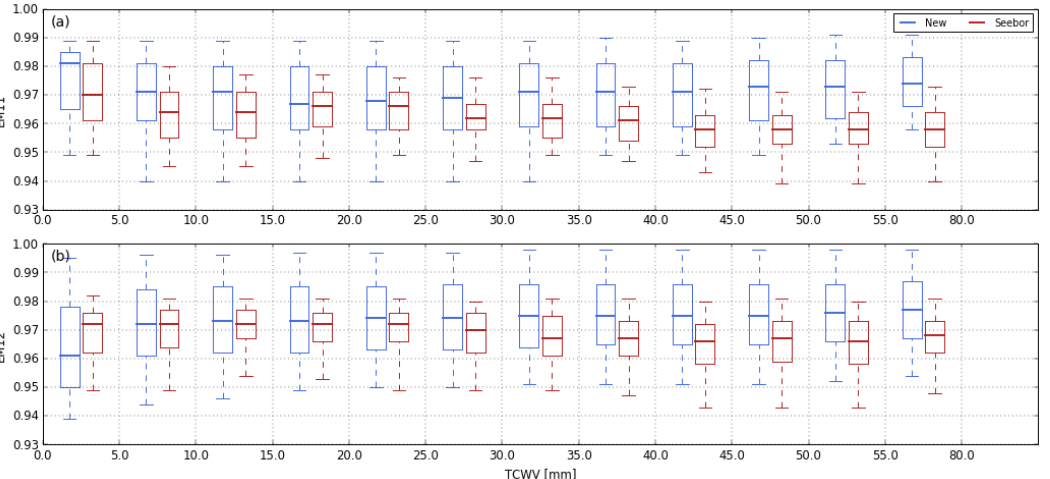
Figure 10. Distribution of ( a ) ~11 µm (EM11), and ( b ) ~12 µm (EM12) emissivities for each TCWV class. The bold line represents the median, the box represents the 25th to 75th percentiles, and the whiskers represent the 5th and 95th percentiles. Values are shown for the new calibration database (blues) and the SeeBor database (red).